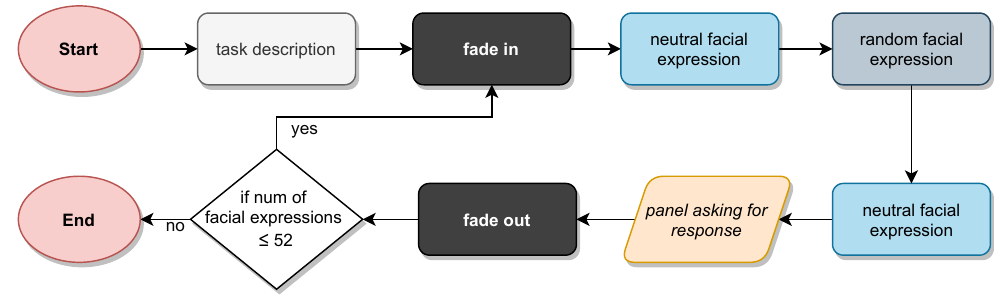
Figure 2. Outline of the experimental